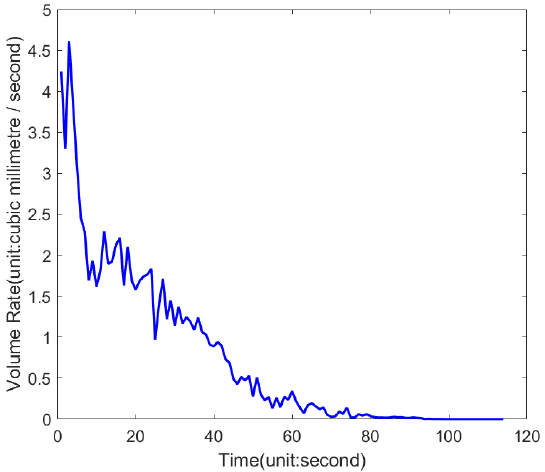
Figure 15. Volume rate variation of silicon dioxide at each moment during high-temperature cell melting.